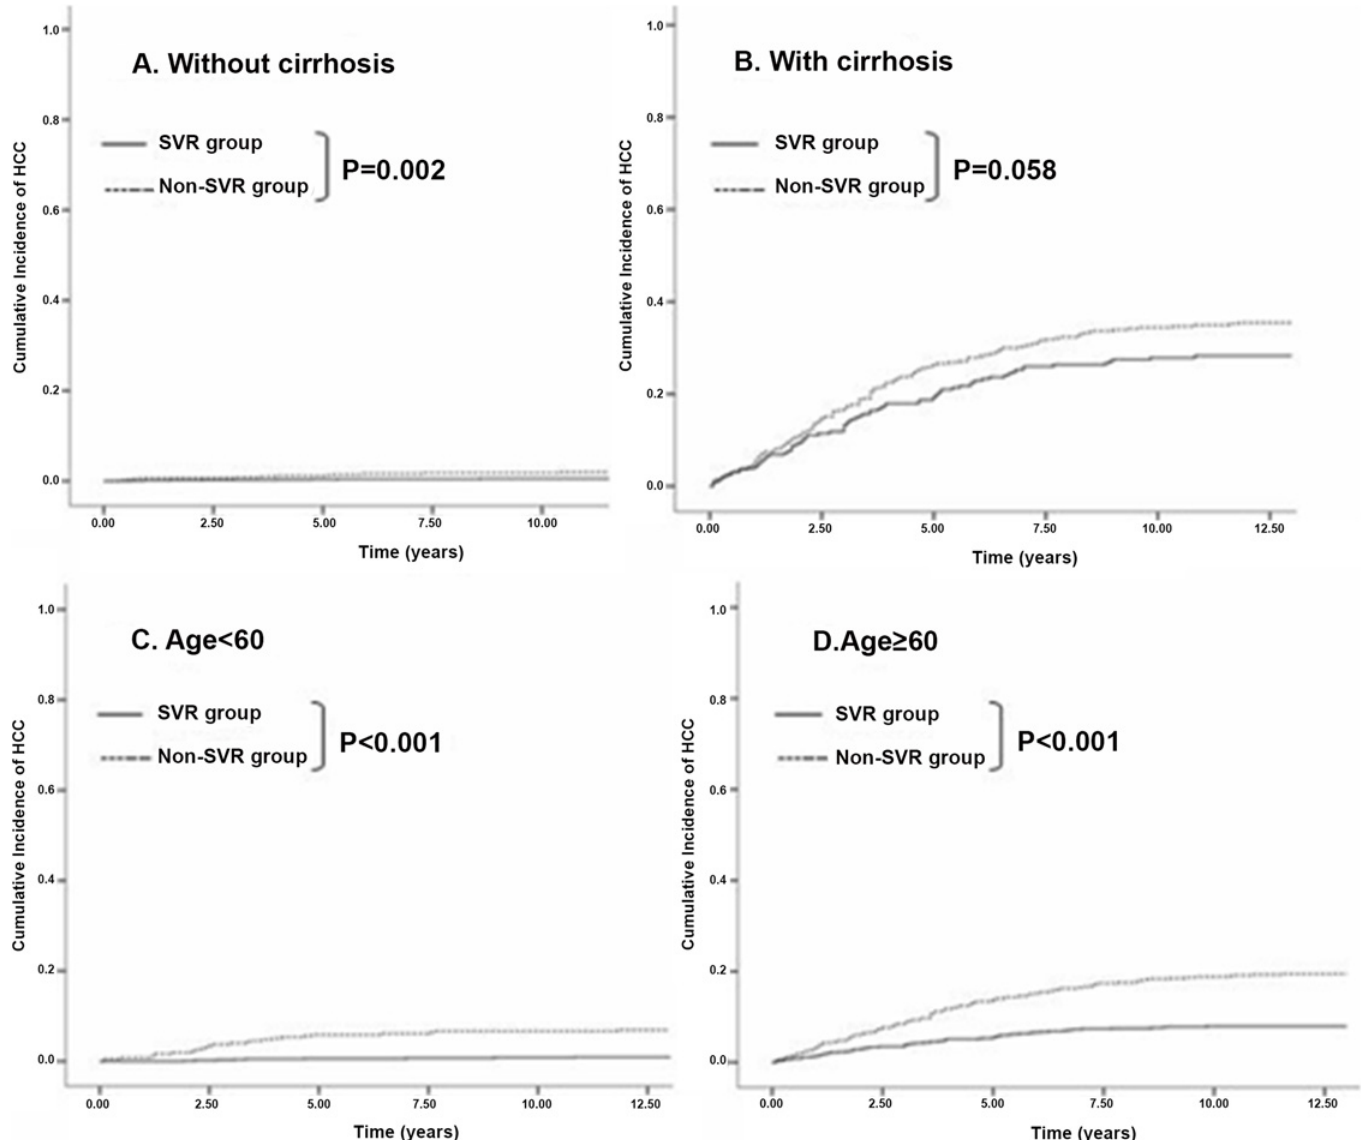
Fig 2. Cumulative Incidence of HCC development after IFN-based therapy. (A) For the group without cirrhosis, patients who achieved SVR had significantly lower incidence of HCC than those who didn ’ t (P = 0.002). (B) The trend of lower incidence of HCC in cirrhotic patients with SVR than those without SVR was observed (P = 0.058). (CD) Significantly lower incidence of HCC was observed in patients with SVR than those without SVR. It was identical when age < 60 (P < .001) and age (cid:3) 60 (P < .001) were concerned.